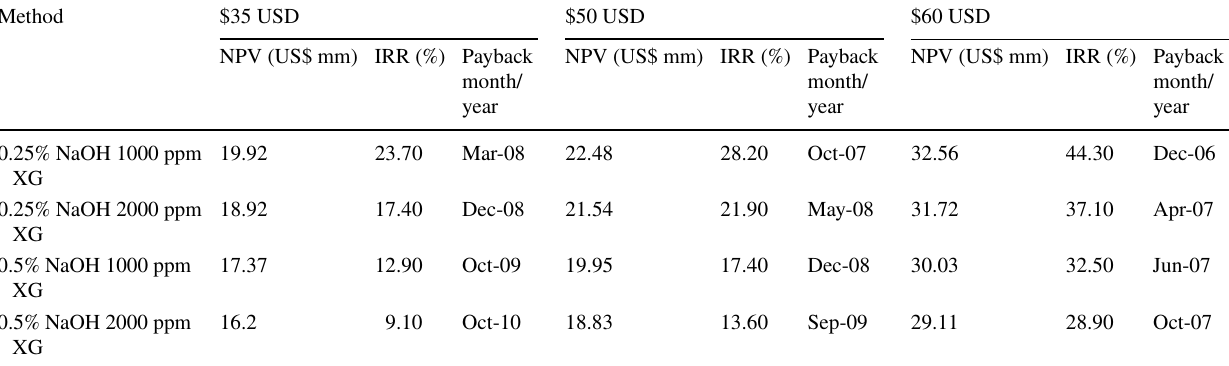
Table 4 Projected economic performance of the various EOR flooding scenarios and oil price sensitivity analysis